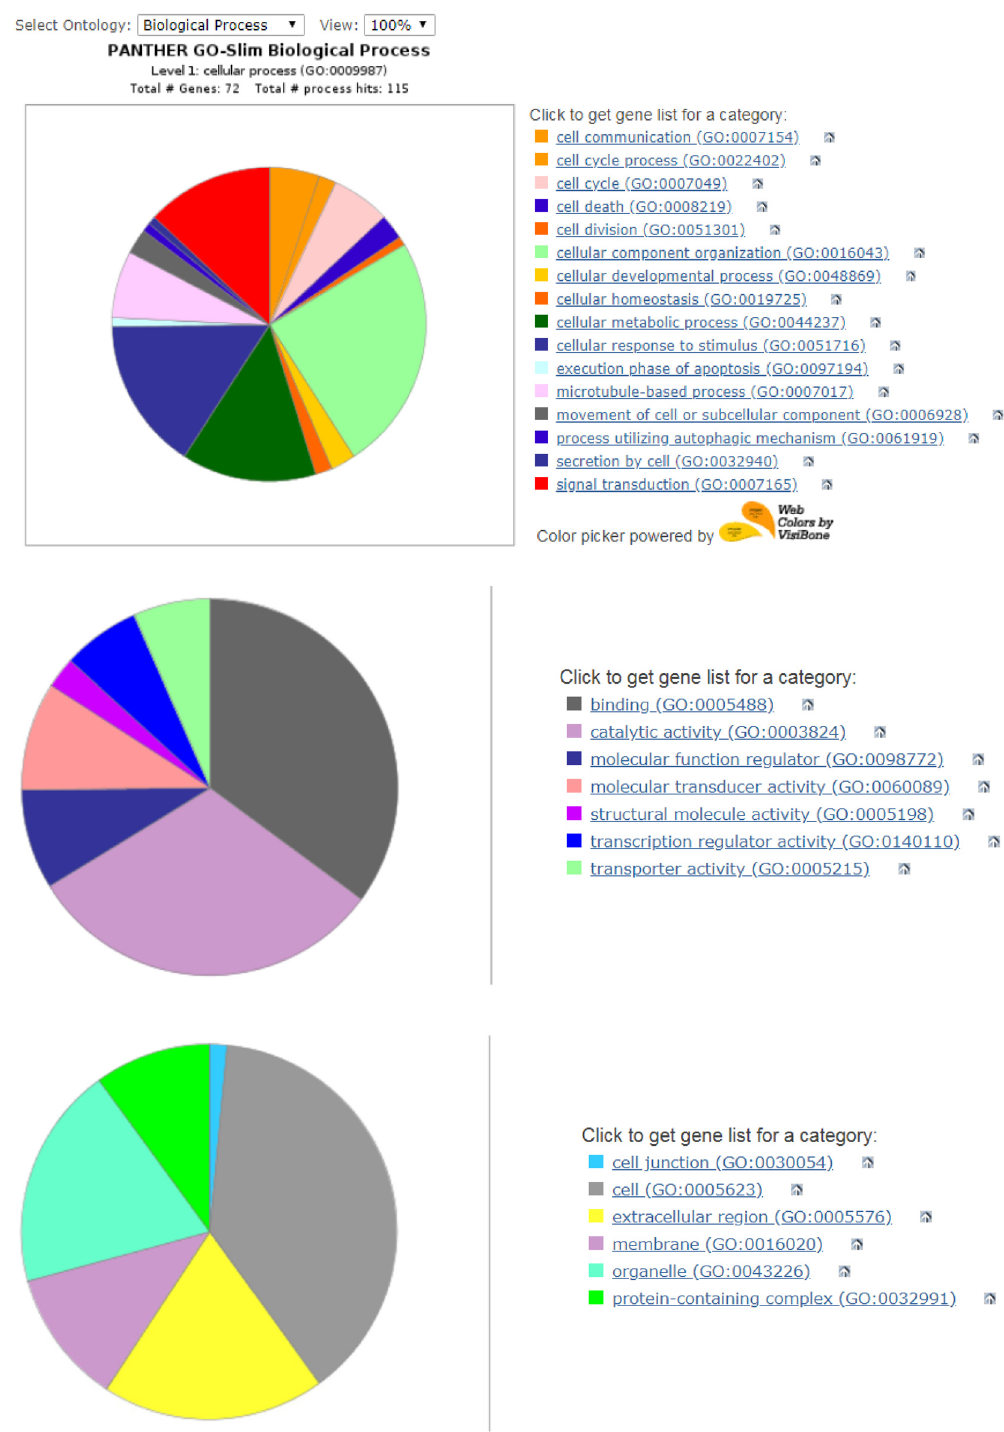
Figure 8. Gene enrichment. Screenshot of a pie chart generated at the Gene Ontology website showing a gene enrichment analysis for a sample gene list along with the associated category legends. The enrichment analysis finds GO terms that are over-represented (or under- represented) for a gene set. In this example, the annotation for Biological Process is shown for 72